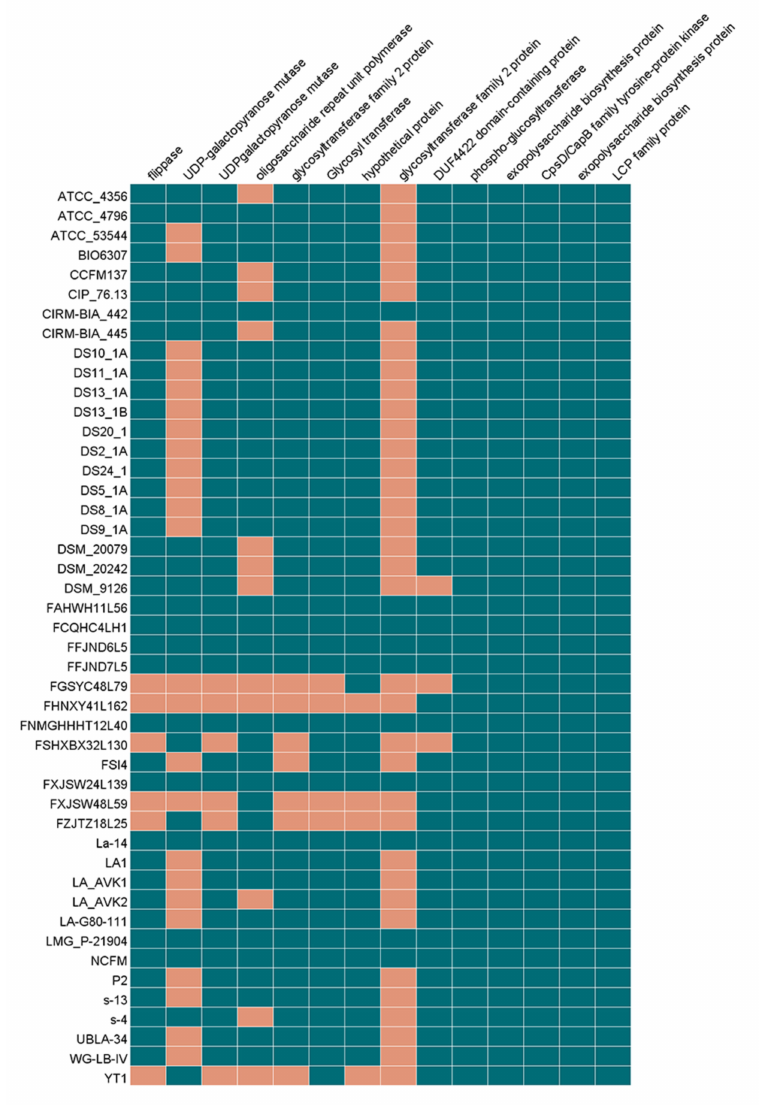
Figure 10. Heatmap of EPS gene cluster in L. acidophilus . Black green regions represented the specific genes exist in strains. The orange regions represented the specific genes do not exist in